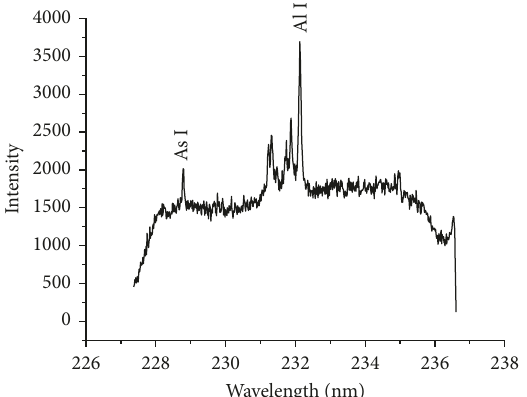
Figure 13: LIBS spectrum of adsorption coupled LIBS reported to detect arsenic in 7 ppm aqueous solution (adapted from [15]).